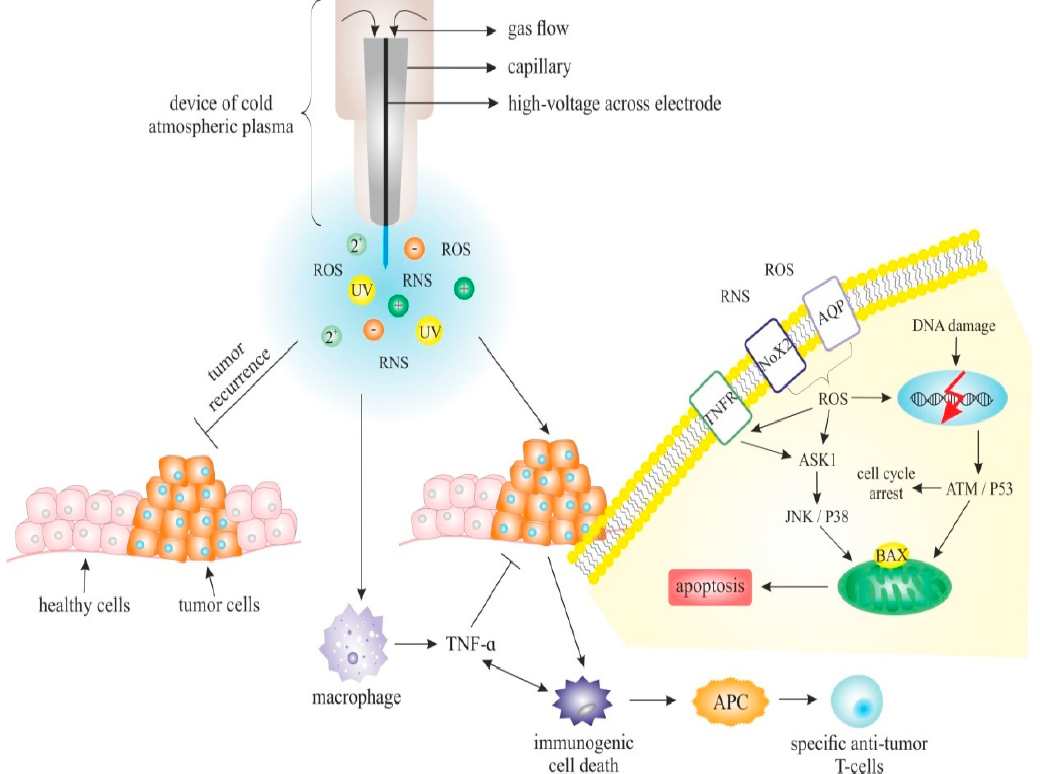
Figure 1. The mechanism of cold atmospheric plasma (CAP) in cancer treatment. Formation of plasma starts in high electric field across the region of gas (pure helium or argon, and/or their mixtures with oxygen) that accelerates electrons. These processes lead to the initiation of a cascade of chemical reactions associated with the generation of various chemical species. CAP is a source of highly reactive species (ROS, RNS, atomic oxygen, hydroxyl radical, superoxide, nitrogen oxides, and singlet delta oxygen), neutral particles (photons and neutrons), electrons, and physical factors (electromagnetic field and UV radiation) [199]. Reactive species produced by CAP have the ability to directly induce DNA damage and cell cycle arrest resulting in the apoptotic signalling of tumour cells. The production of reactive species can activate macrophages leading to higher elevation of TNF- α –mediated NF- κ B activation and the expression of proinflammatory genes associated with tumourigenesis. On the other hand, CAP seems to be an effective inhibitor of TNF- α –mediated NF- κ B activation with a potential role in anticancer strategies. CAP can also induce the immunogenic cell death (ICD) of tumour cells that lead to systematic immune response. ICD can also be achieved by the regulation of various cytokines, including TNF, that play a crucial role in the creation of immunogenic microenvironment [200]. Abbreviations: ROS, reactive oxygen species; RNS, reactive nitrogen species; AQP, aquaporin; TNFR, tumour necrosis factor receptor; Nox, NADPH oxidases; ATM, ataxia-telangiectasia mutated kinase; JNK, c-Jun N-terminal kinase; ASK, apoptosis signal- regulating kinase; APC, antigen-presenting cell; TNF- α , tumour necrosis factor alpha; Bax, Bcl-2- associated protein X; UV, ultraviolet radiation; APC, antigen-presenting cell. 8.1. CAP Effect on Cellular and Extracellular Level The expected basic cellular responses (apoptosis, growth inhibition, selective cancer cell death, cell cycle arrest, DNA and mitochondrial damage, a selective increase of ROS or immunogenic cell death) have been observed after the application of CAP to cell lines and/or tissue [28,201]. Several studies demonstrated the impact of CAP on different cellular processes associated with the suppression of cancer development via modulation of gene expression and other intracellular events [111,177,178,202]. Despite the current focus on CAP as a promising strategy for pathogen eradication contributing to wound healing, the exact mechanisms of the anticancer effect are not known [203].